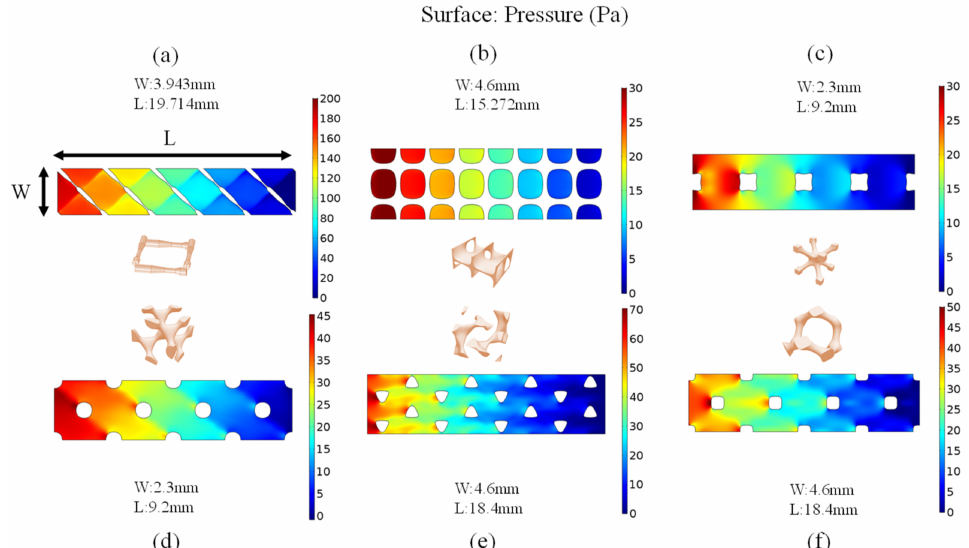
Figure 8. Contours of pressure differential on an xy-slice which is cut at z = 1/2 of height of the computational domain at u = 0.1 m/s in ( a ) commercial spacer-filled channel, ( b ) CLP spacer-filled channel, ( c ) IWP spacer-filled channel, ( d ) D spacer-filled channel, ( e ) L spacer-filled channel, and ( f ) IW spacer-filled